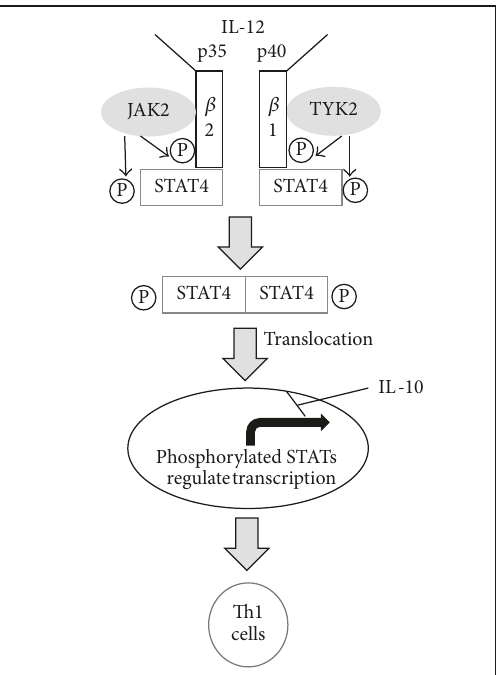
Figure 1: IL-12 activation of JAK-STAT pathway. IL-12 activates a series of phosphorylation events which permit STAT4 molecules to dimerize and translocate to the nucleus, upregulating a proin- flammatory cascade. IL-10 has an inhibitory effect on this response transcriptionally.